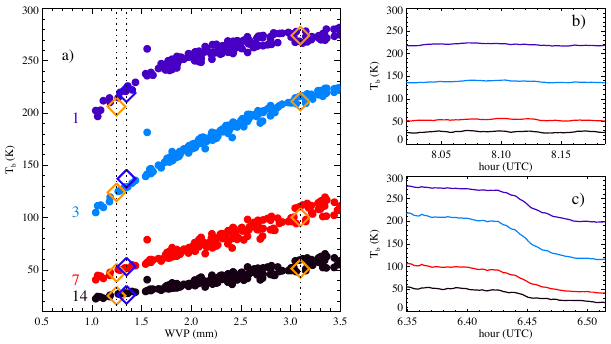
Fig. 5. (a) Simulated T b for the ± 1 , ± 3 , ± 7, and ± 14GHz GVR channels calculated for 330 RS92 soundings reaching 50 hPa (pur- ple, blue, red, and black filled circles, respectively) at the RF3AC1 altitude of 1335m, and GVR leg-mean values for RF3AC3 (blue diamonds, collected at 1548m altitude and shown only for compar- ison) and 5-min mean values for RF3AC1 (yellow diamonds). Time series of GVR T b s for (b) RF3AC3 and (c) RF3AC1, with ± (1, 3, 7, and 14)GHz lines indicated in purple, blue, red, and black re-